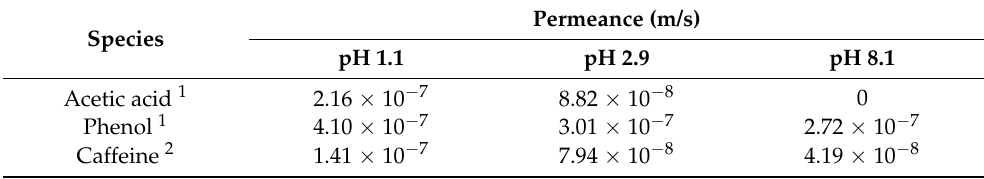
Table 2. Permeances of acetic acid, phenol, and caffeine in mixed aqueous solution.